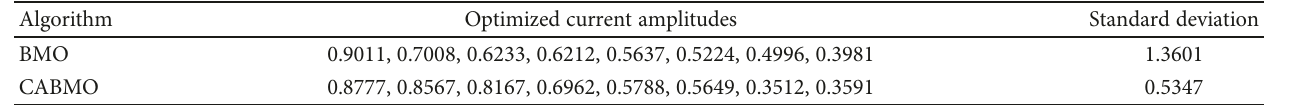
Table 4: The optimized results of the 16-element LAA for case two.